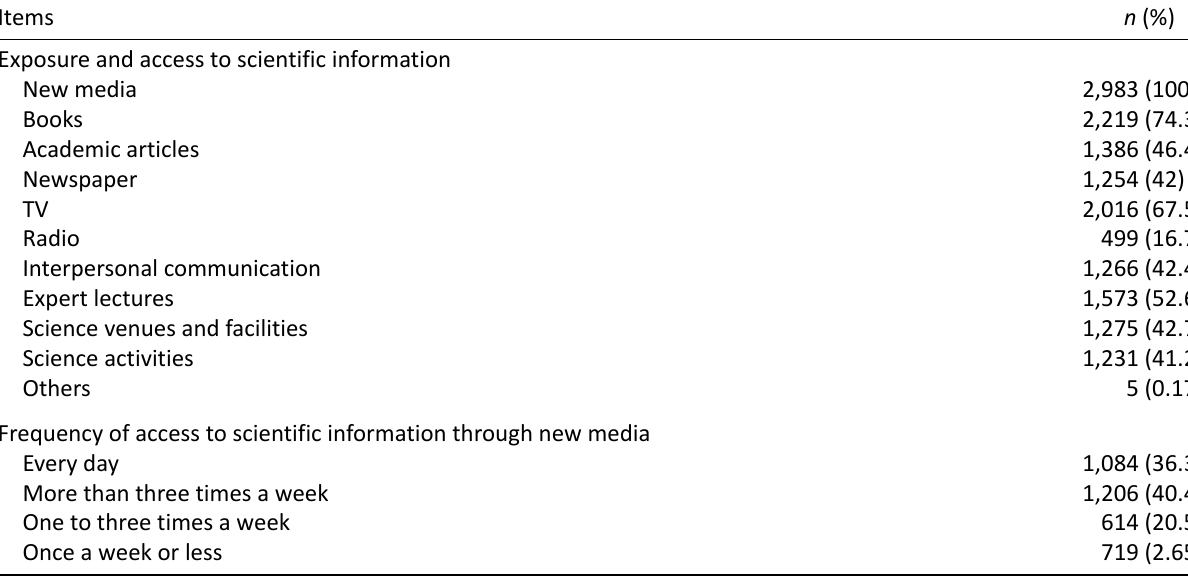
Table 4. (Cont.) Socio‐demographic Information of the respondents ( N = 2,983).